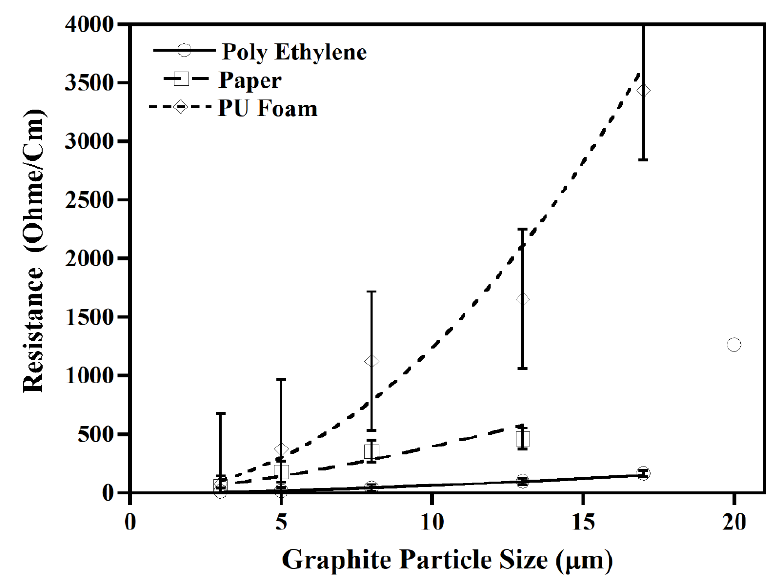
Figure 2. Effect of graphite particle size on the conductivity of ink applied to paper, polyethylene, and polyurethane foam.